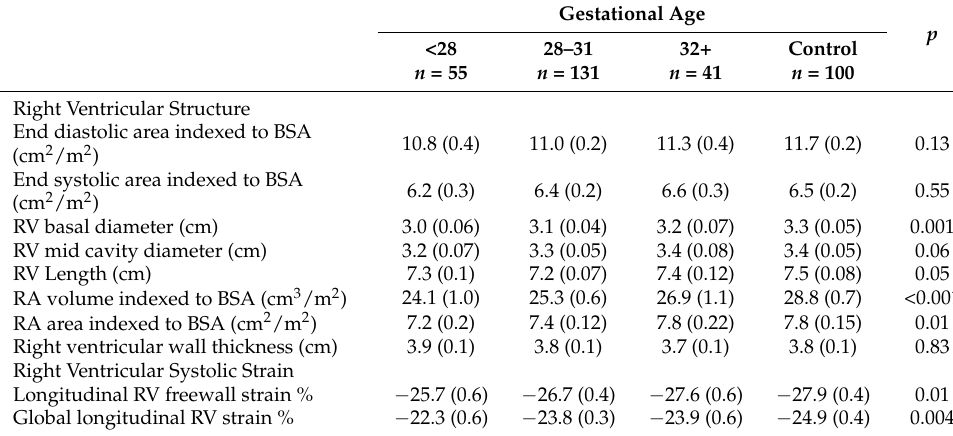
Table 3. RV structural and strain indices compared by gestational